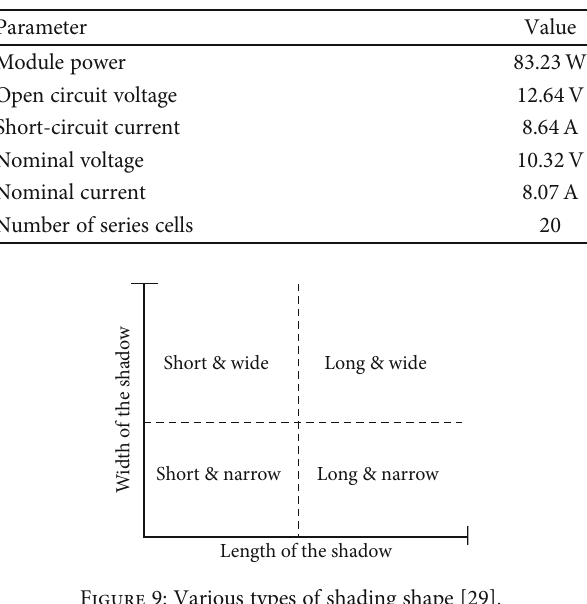
Table 1: PV module parameter